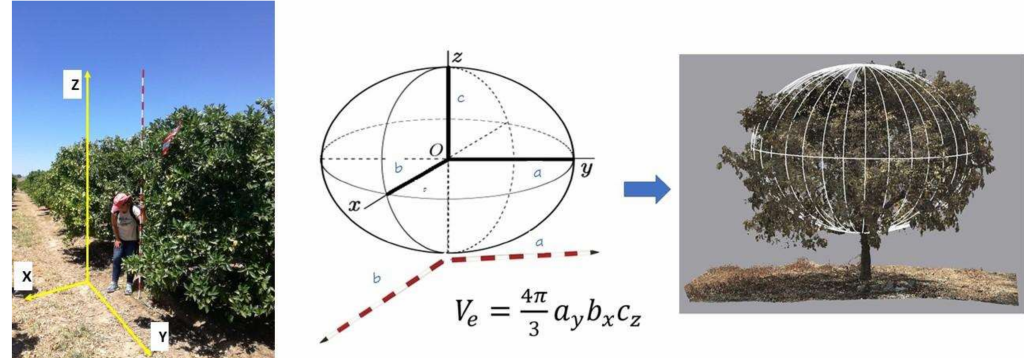
Figure 4. The traditional method for tree crown size assessment. a y , b x , c z are the semi-axes of the ellipsoid, Equation (1).